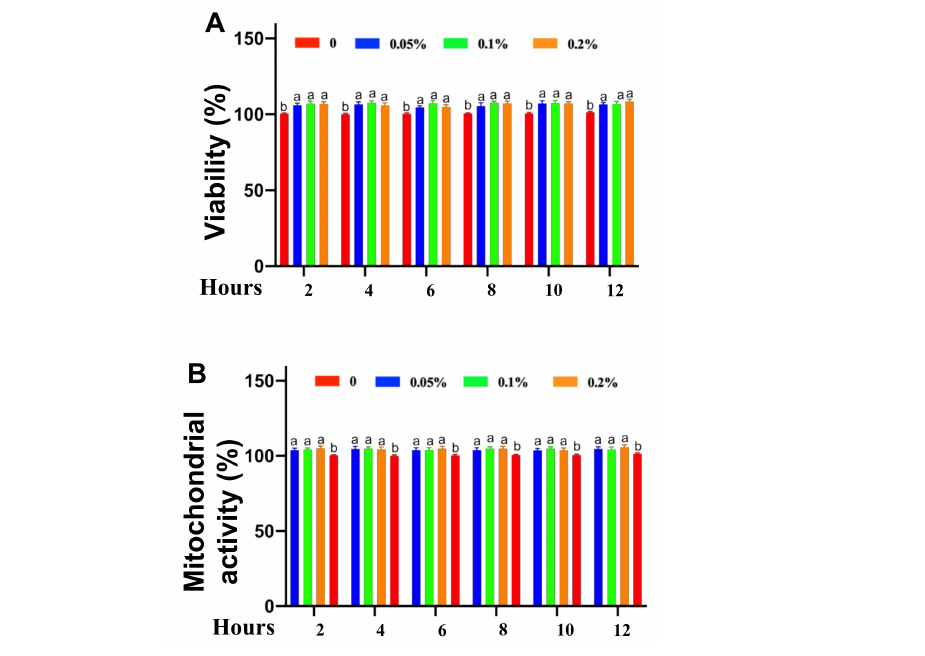
Figure 2. Cytotoxicity analysis of safe concentrations of CNMs toward intestinal epithelial cells at different times. LDH assay ( A ) and MTT assay ( B ) of IPEC-J2 cells treated at various concentrations of CNMs for different times. Data are means ± SEM from 6 biological data. Means with different lowercase letters differ significantly ( p < 0.05).